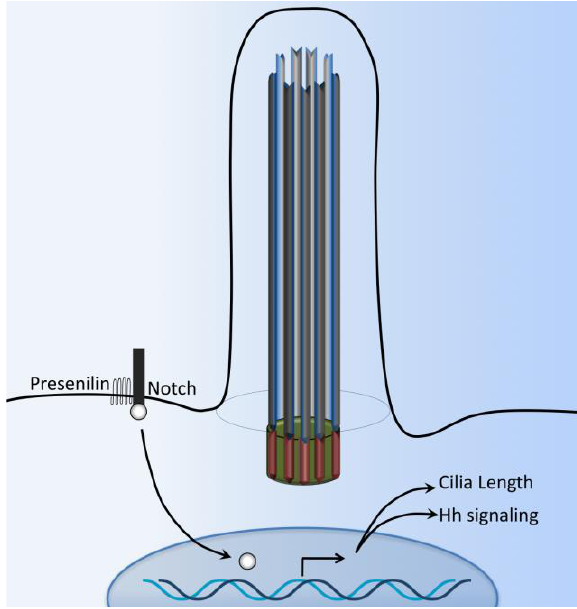
Figure 6. Cilia-dependent Notch signaling. A single-transmembrane Notch forms a receptor complex with the eight-transmembrane presenilin. Upon activation, presenilin mediates the intramembranal cleavage of notch containing the cdc10/Ankyrin repeats. The Notch intracellular domain is then released to the nucleus to activate various gene